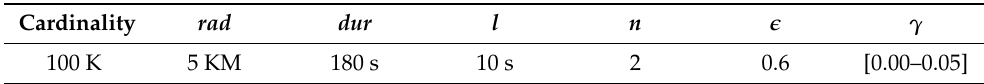
Table 7. Setting of synthetic data parameters and algorithm parameters in adjustable parameter